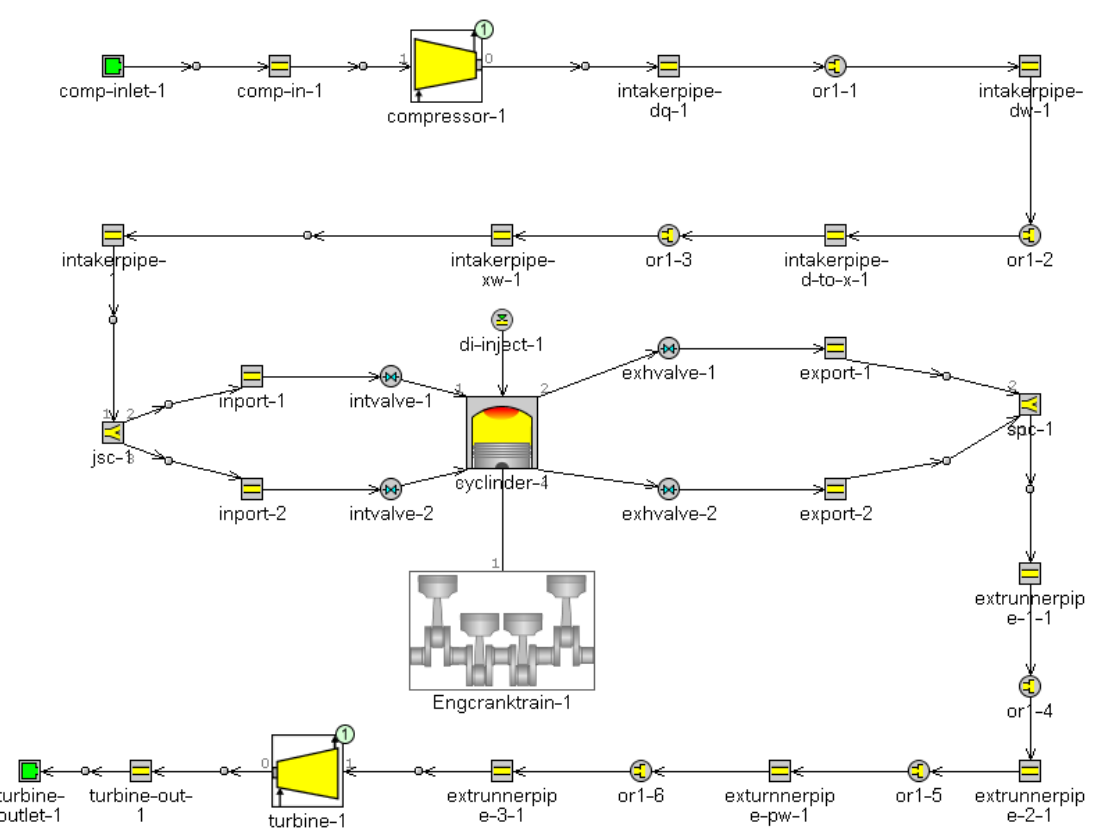
Figure 9. GT-Power one-dimensional simulation model.